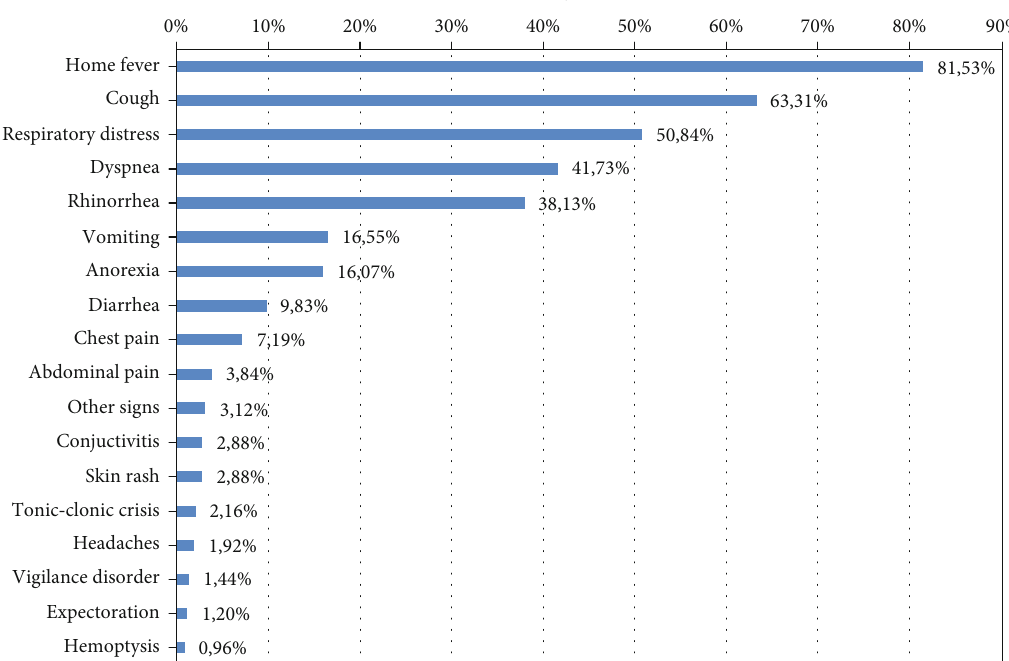
Figure 2: Clinical signs at admission.